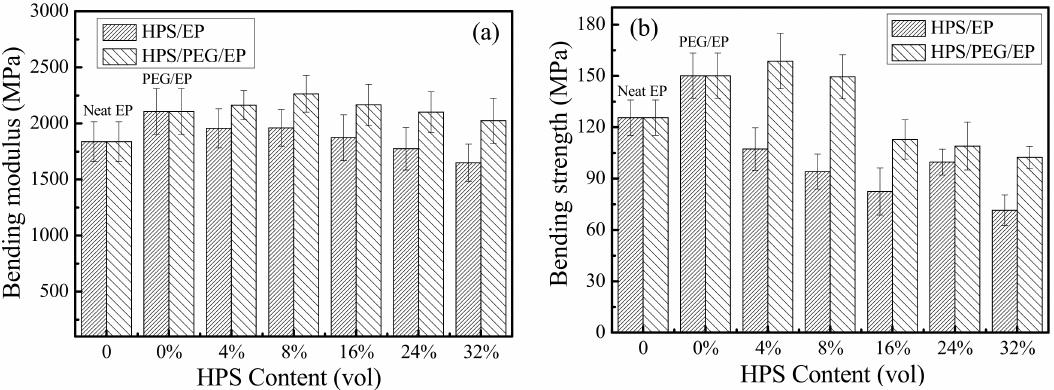
Figure 9. ( a ) The bending modulus of the EP, PEG/EP, HPS/EP, and HPS/PEG/EP composites; ( b ) the bending strength of the EP, PEG/EP, HPS/EP, and HPS/PEG/EP